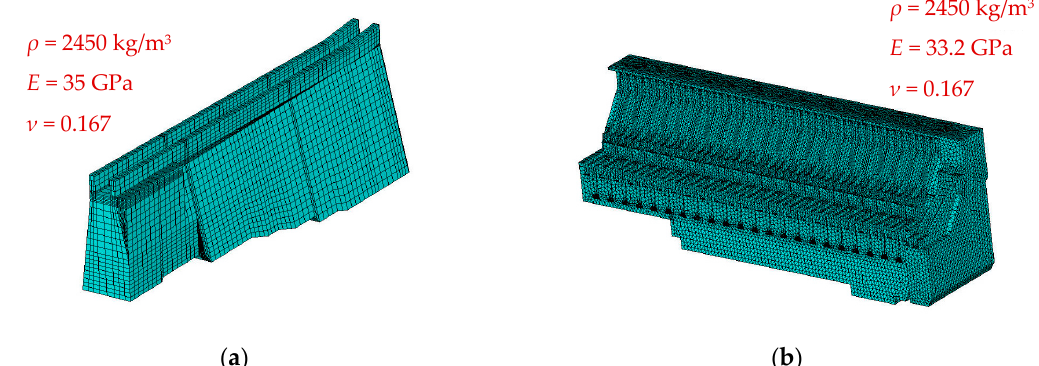
Figure 19. Numerical model of concerned structures. ( a ) Guide wall; ( b ) spillway dam. Table 2. Natural frequencies of the dam.